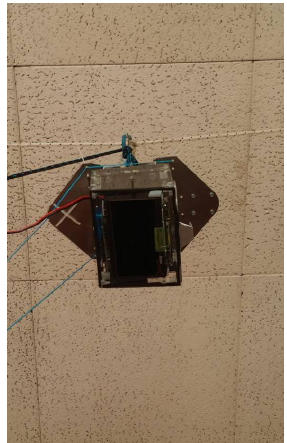
Figure 6. LasUAV maintained in a stationary position pointing to a flat floor located 317.0 cm from the point of emission of the laser pulses.